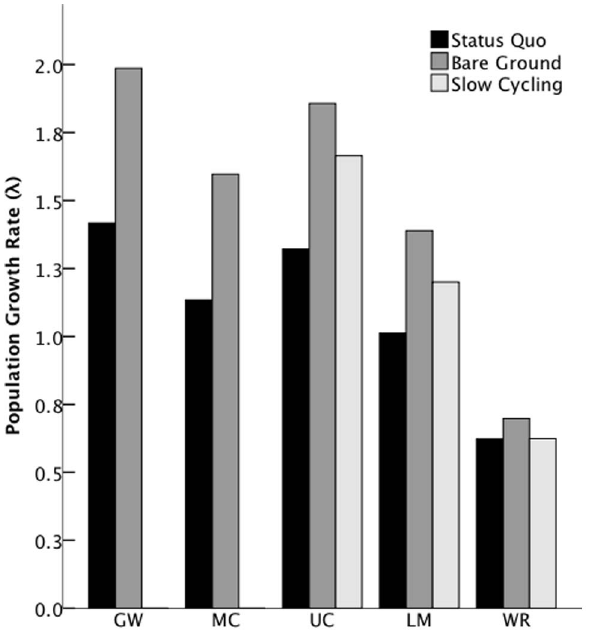
Figure 4. Population growth rates for all populations with current management (Status Quo ( l 1 )), with increased bare ground, and with slower cycling where recreation is permitted.